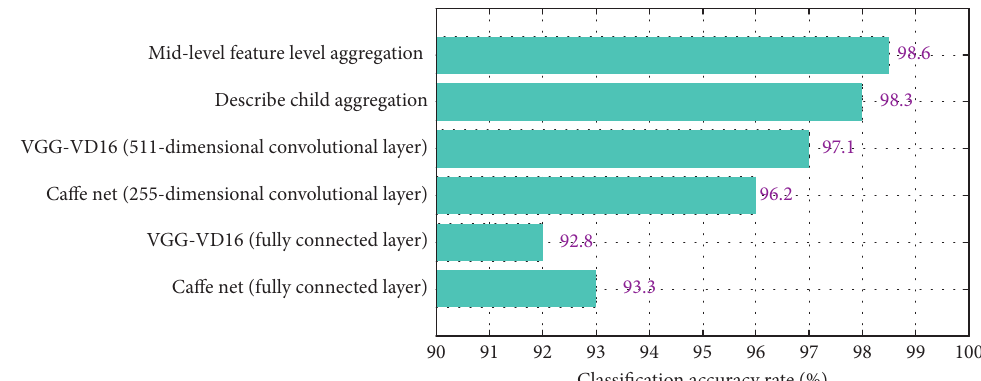
Figure 10: Convolutional layer and fully connected layer road traffic accident scene glass breakage and crack feature classification accuracy comparison.